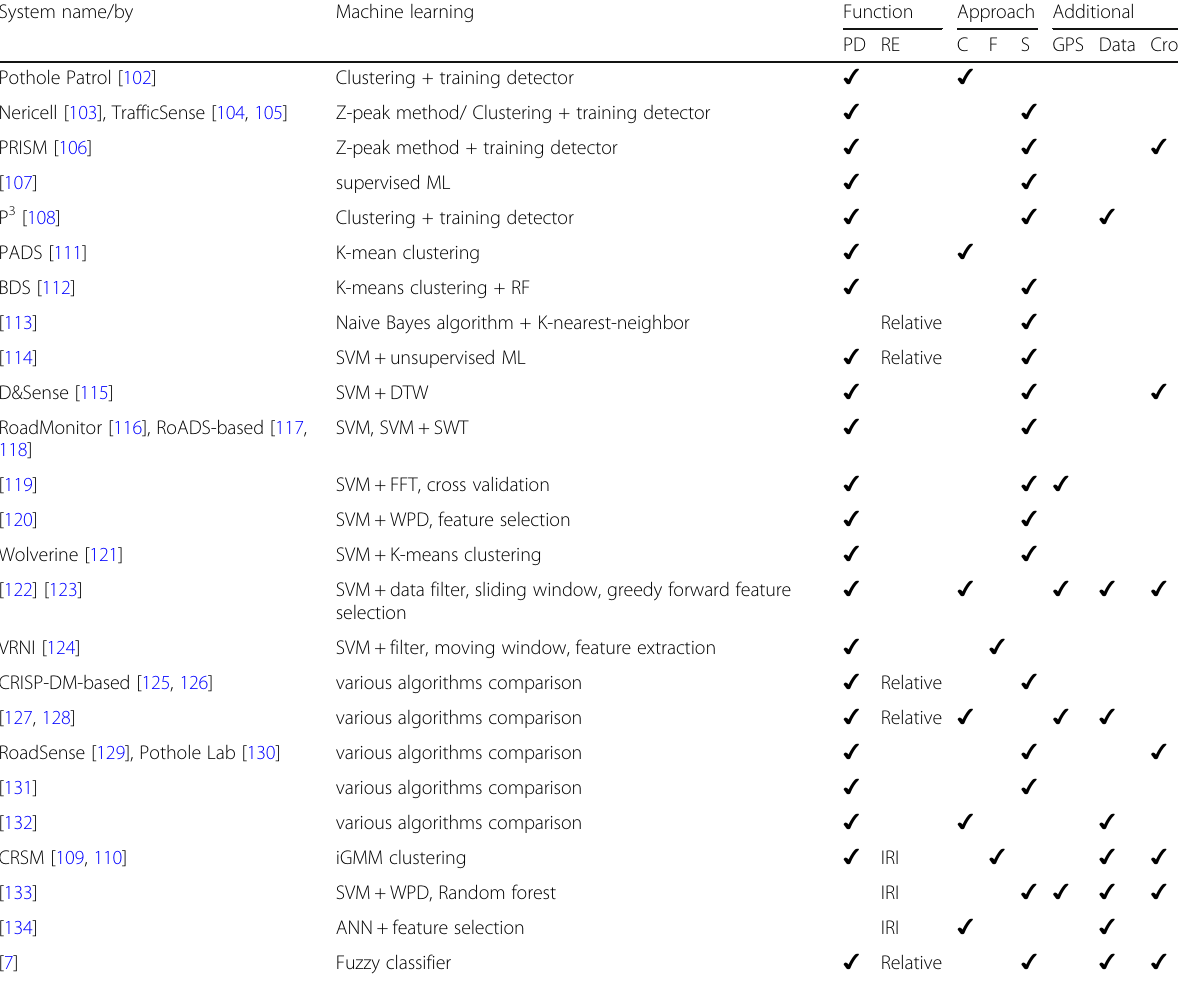
Table 6 Summary of ML methods for pothole detection and roughness index estimation System